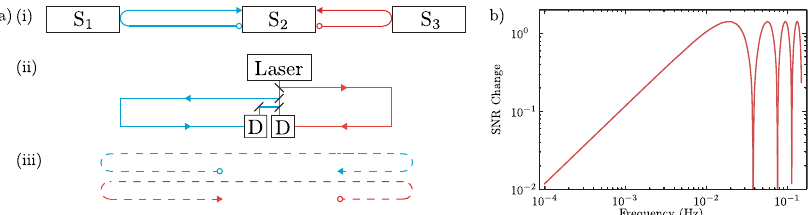
Fig. 3 TDI applied to GRACE-like mission. a Schematic showing how the different length optical paths are converted to optical paths of the same effective length through TDI. (i) shows the true optical paths between the three satellites. (ii) shows how these optical paths are measured with the same laser. Finally (iii) shows how the effective optical path lengths for the two beams are equal after TDI. D represents the detection process, either homodyne or heterodyne detection. The different colours for the optical paths are for illustrative purposes only. b Ratio of the SNR with TDI to the SNR without TDI for both quantum noise and accelerometer noise assuming a satellite velocity of v 0 = 7600 m/s and satellite separation of L 12 = 200 km. There are certain frequencies where the SNR is enhanced.